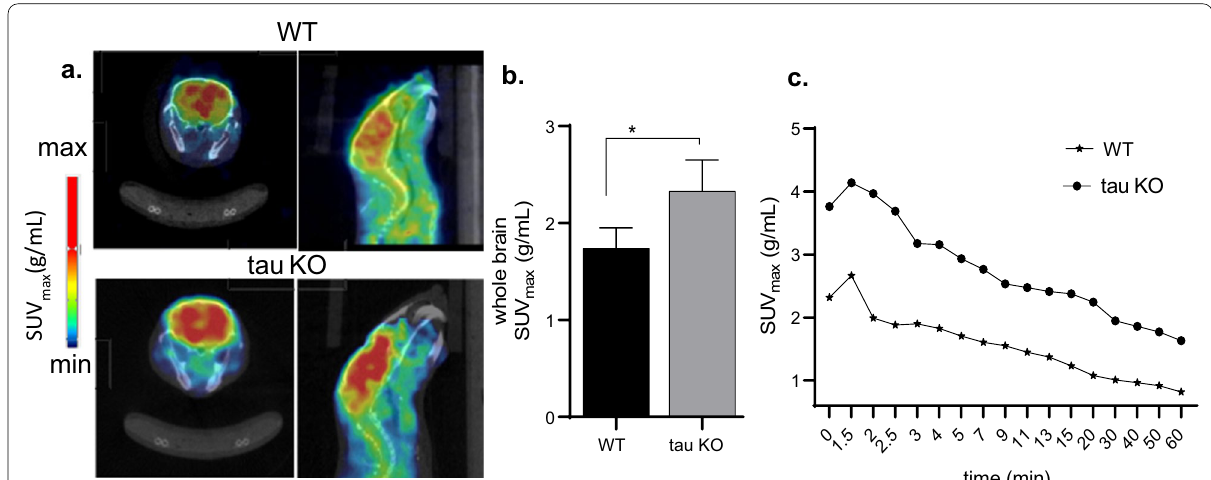
8/group) with their =